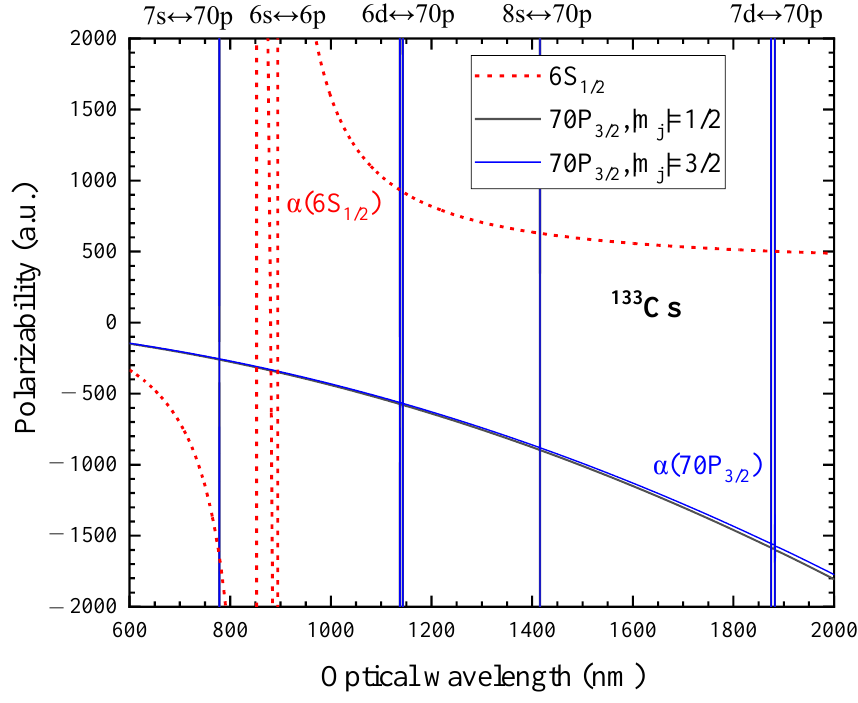
Figure 3. Dynamic polarizabilities of Cs 6 S 1/2 ground state (red dashed lines) and 70 P 3/2 Rydberg state (blue and black solid lines) between 600 nm and 2000